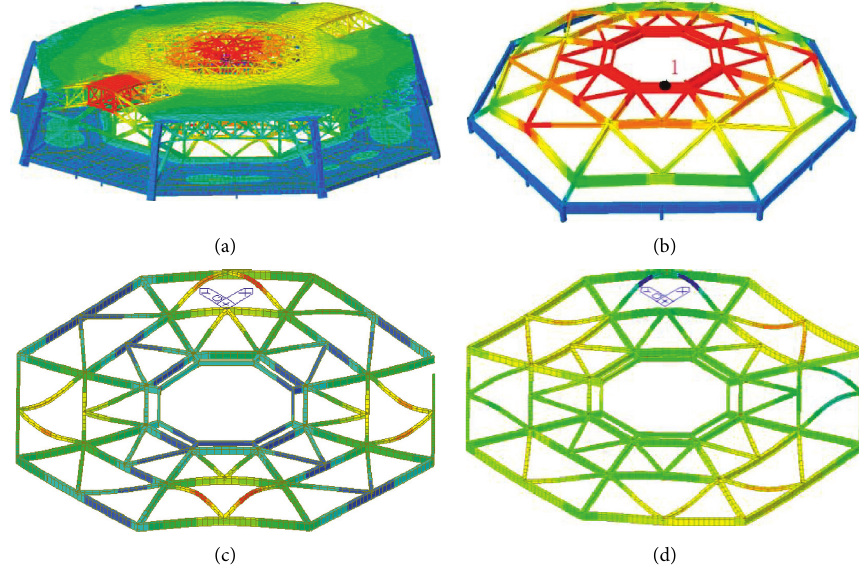
Figure 3: Vertical vibration mode shapes of the structure predicted with the global simplified FE model. (a) Mode shape of the global simplified FE model with f 1 � 6.00Hz. (b) Mode shape of steel space frame-glass composite floor with f 1 � 6.00Hz. (c) Mode shape of steel space frame-glass composite floor with f 2 � 12.46Hz. (d) Mode shape of steel space frame-glass composite floor with f 3 � 14.23Hz.